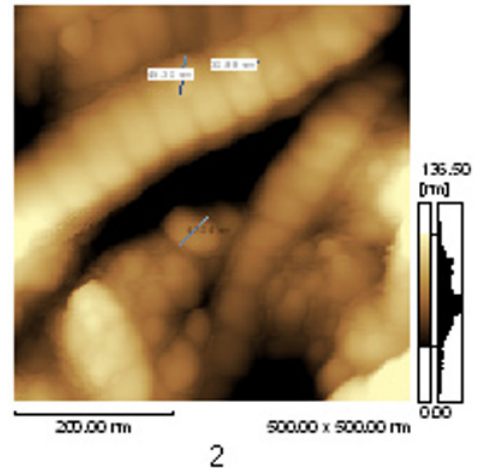
Figure 9. AFM image of AgNps deposition onto collagen fibrils of dermal layer of